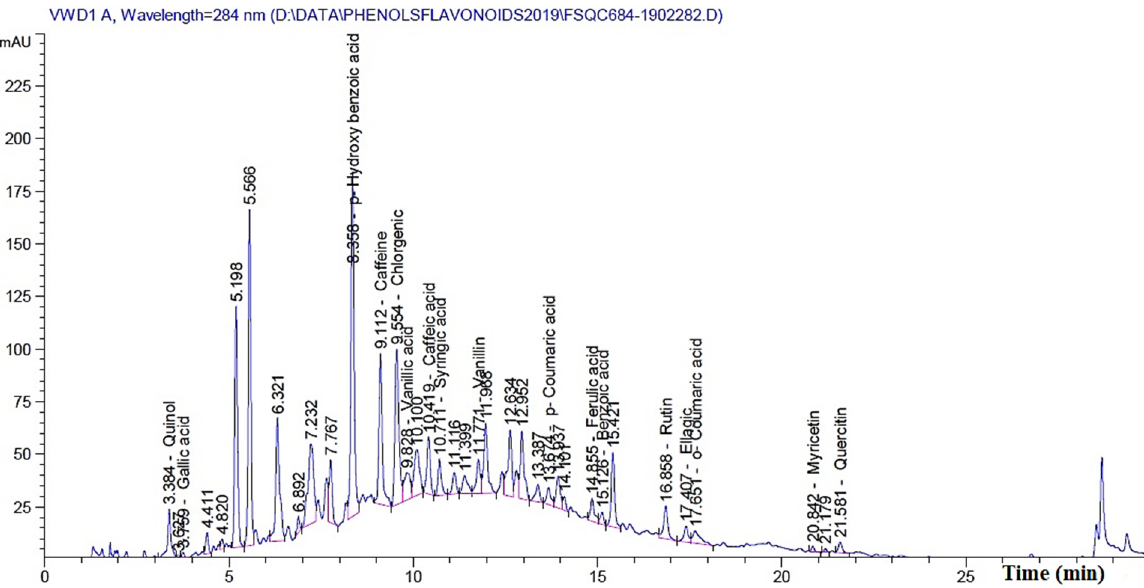
Figure 13. HPLC Fingerprint profile of phytochemicals present in Melia azedarach heartwood extract.